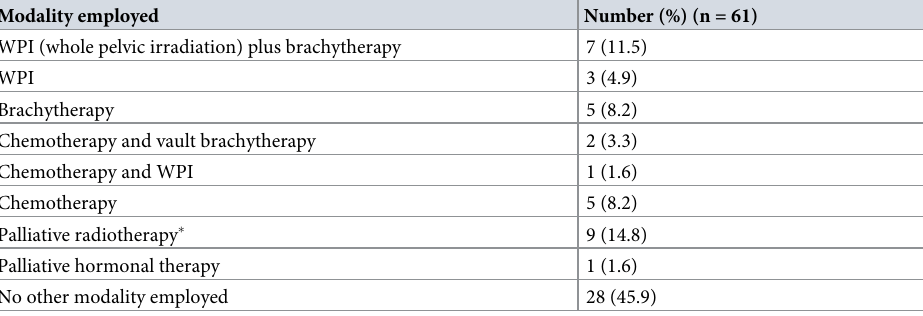
Table 4. Other modalities employed in the treatment of patients.